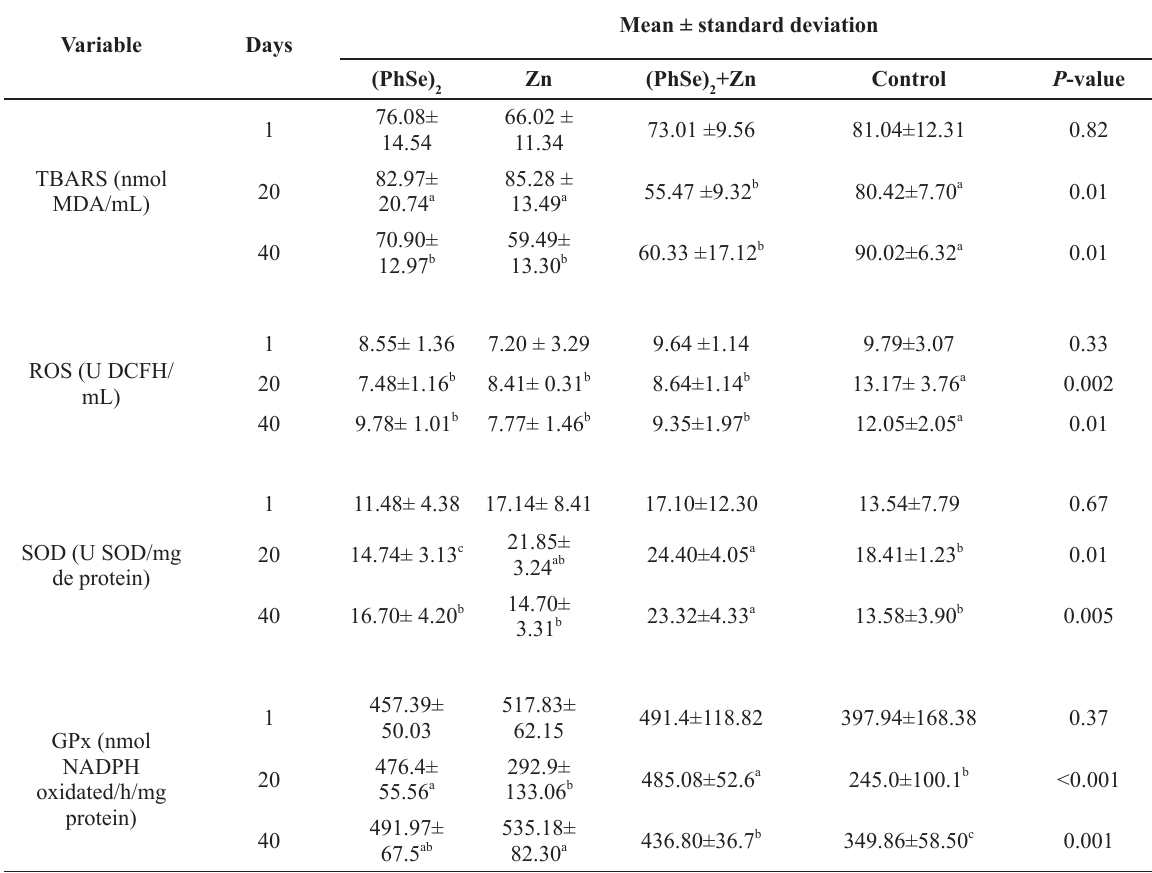
Mean and standard deviation of blood components for each group at the day 1, 20 and 40 of the experiment.